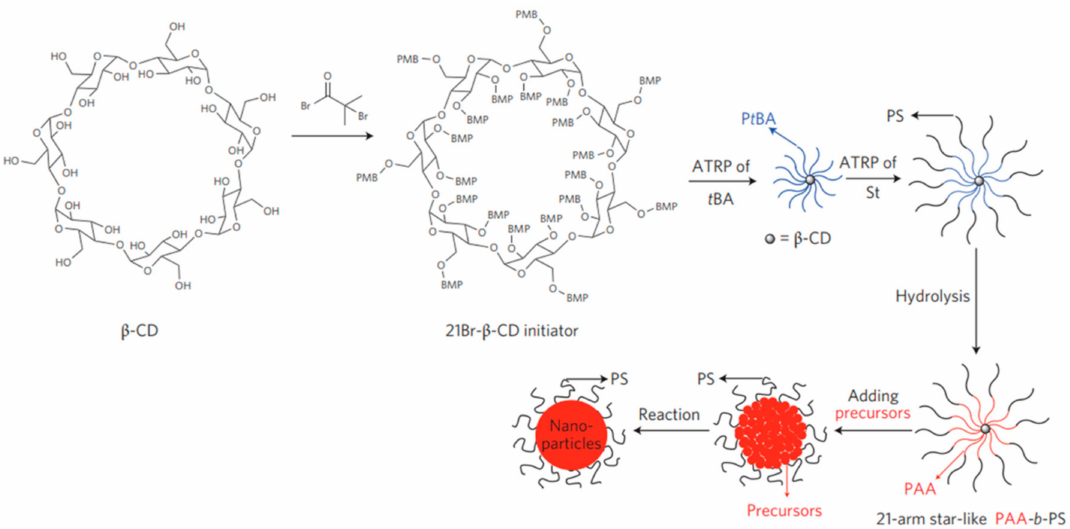
Figure 10. Schematic illustration of the formation of hybrid nanocomposites using a template. Reprinted with permission from [71]. Copyright 2013, Springer